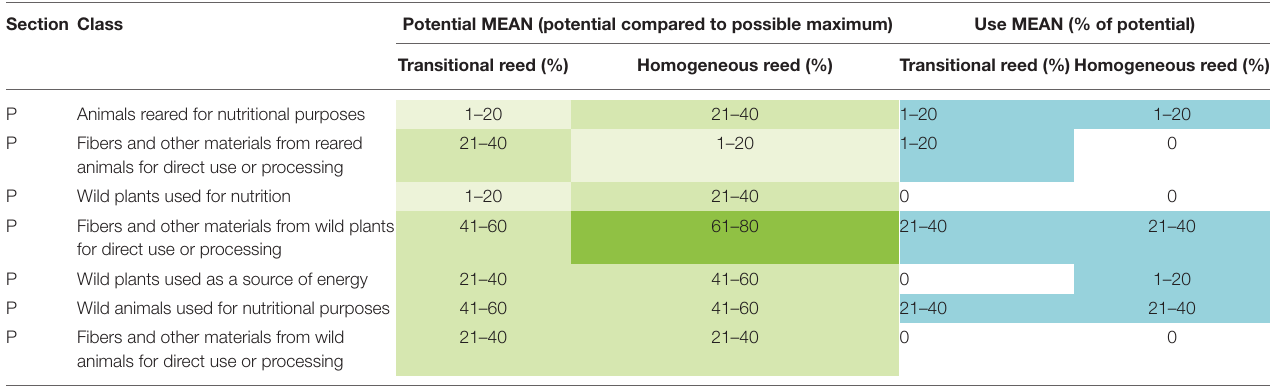
TABLE 2 | Results of the authors’ ecosystem service assessment for provisioning services in transitional and homogeneous reed